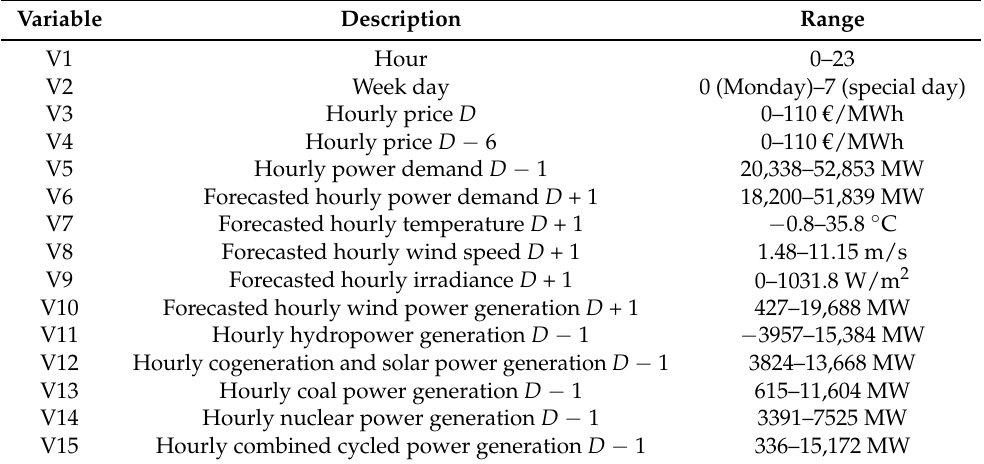
Table 5. Variables of daily session models for price forecasts (DSMPF